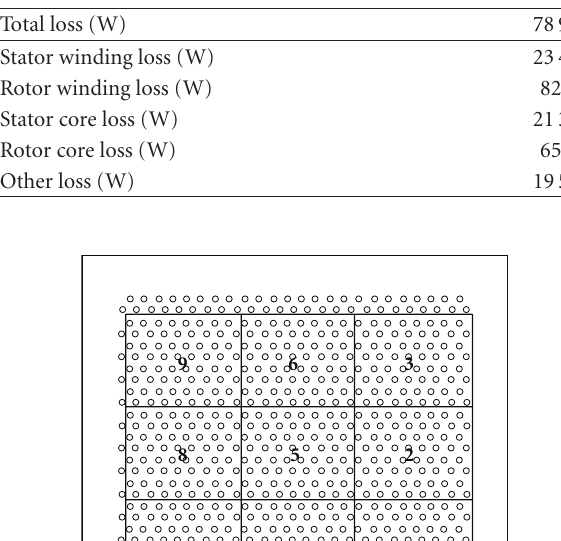
Table 1: Table Heat generation rates.